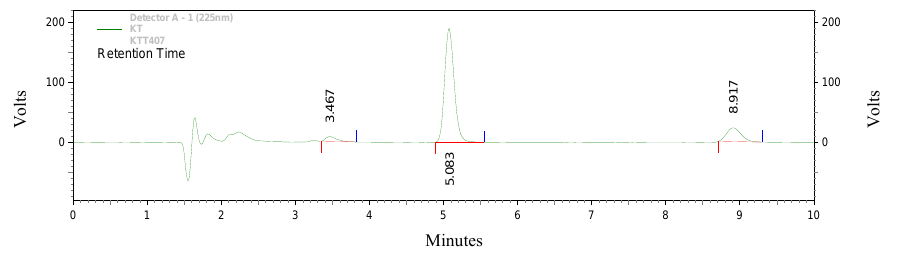
Figure 6. Degradation of metaxalone in acid conditions (Retention time of metaxalone is 5.083 min and IS (Gliclazide) is 8.917 min)